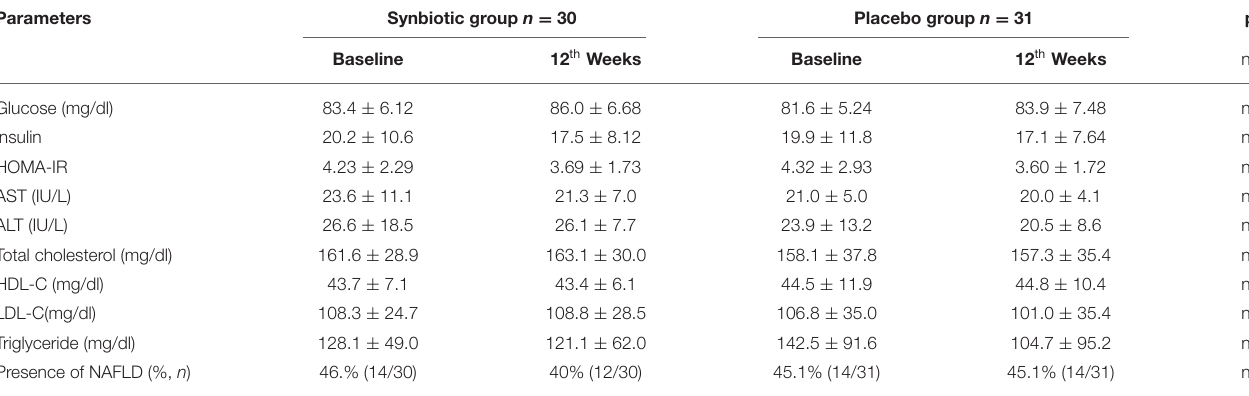
TABLE 2 | Evaluation of biochemistry and lipid parameters of the synbiotic and placebo groups at the beginning of the study and at the end of the 12th week.